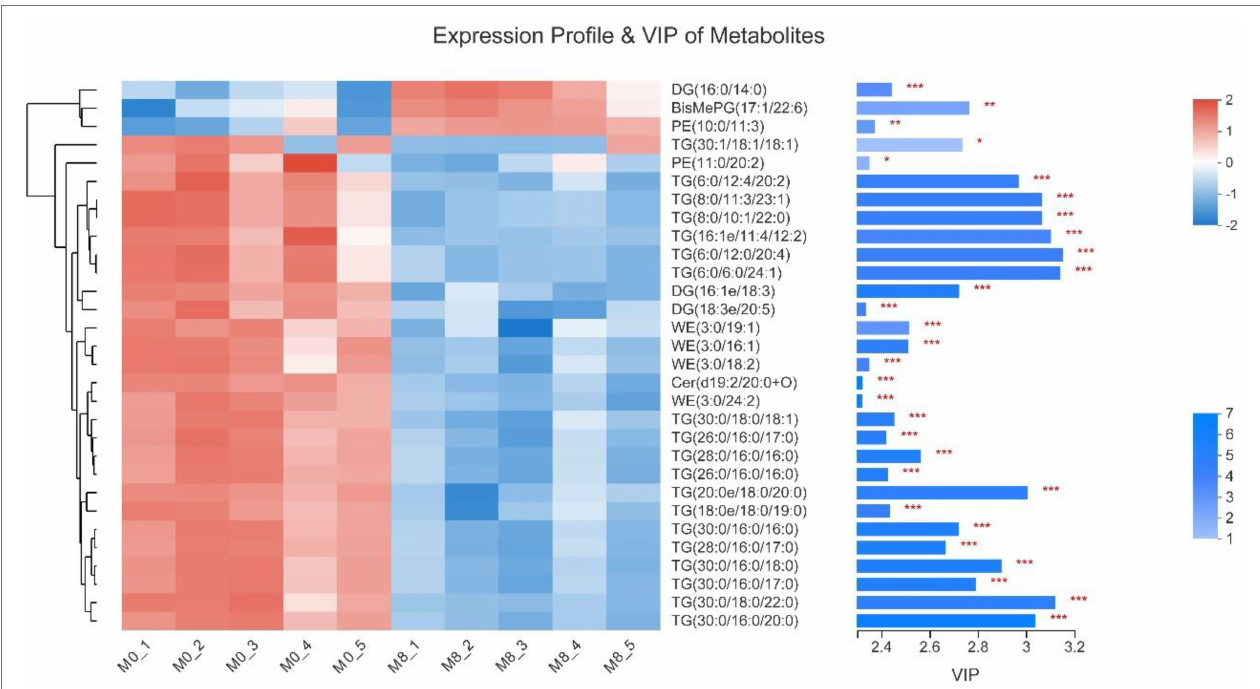
FIGURE 8 | Effects of methionine restriction on the expression profile and VIP of metabolites obtained via lipidomics after feeding for 8 weeks ( n = 3); * p < 0.05, ** p < 0.01, and *** p < 0.001.